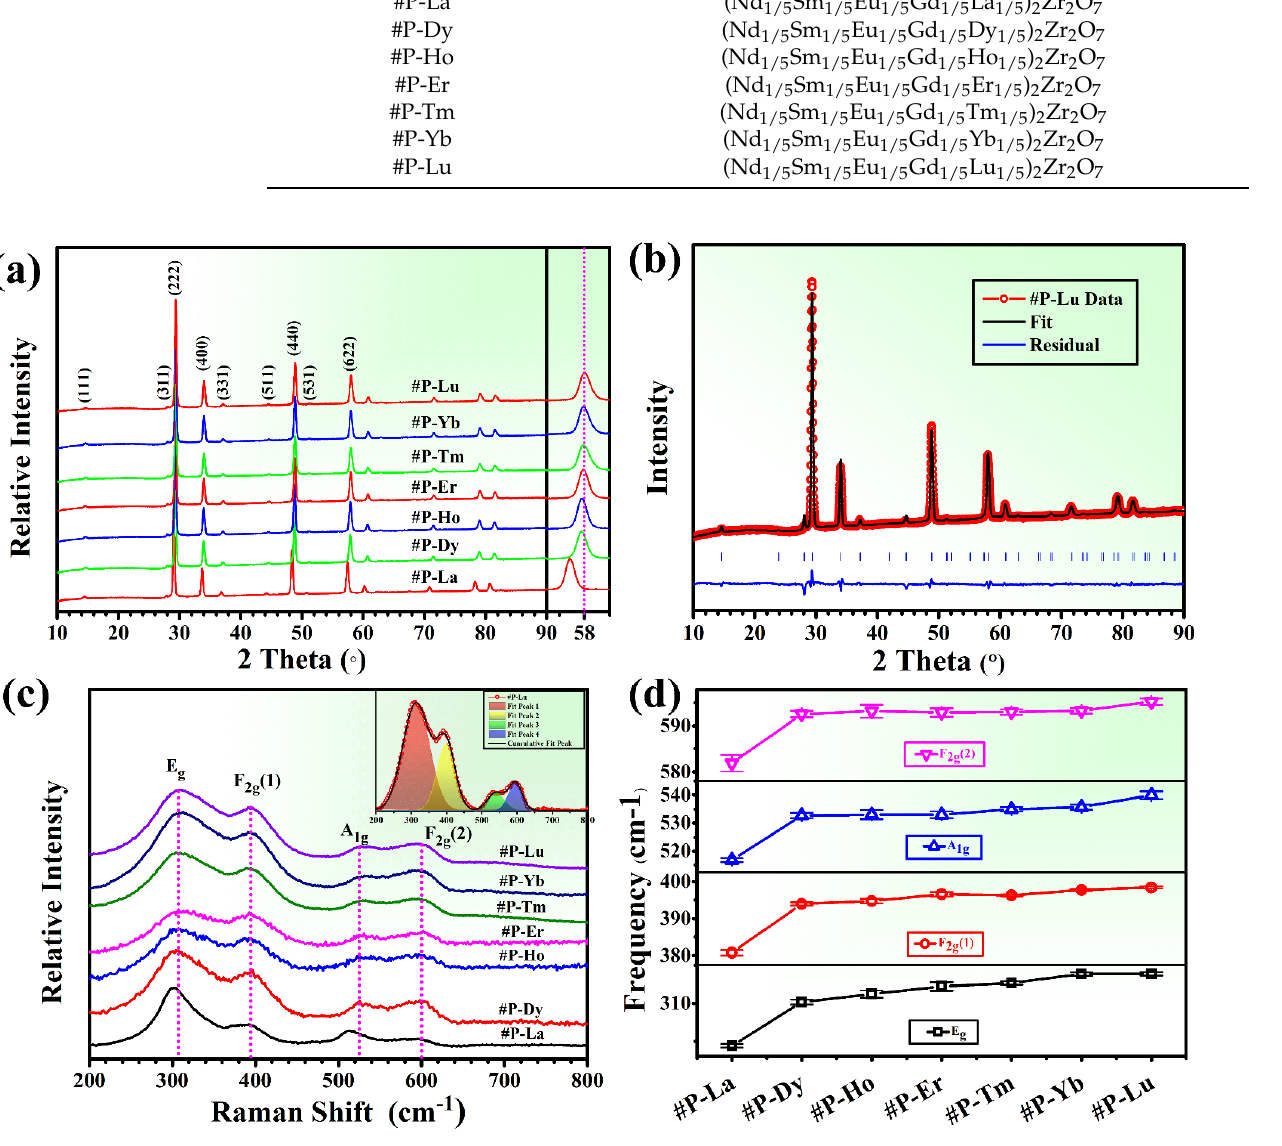
Figure 1. ( a ) XRD patterns of compounds #P-La~Lu. ( b ) XRD patterns together with Rietveld fit of #P-Lu. ( c ) Raman spectra of compounds #P-La~Lu. The inset shows the Gaussian peak fit of #P-Lu. ( d ) Raman shift with corresponding error bars of four Raman modes of compounds #P-La~Lu.